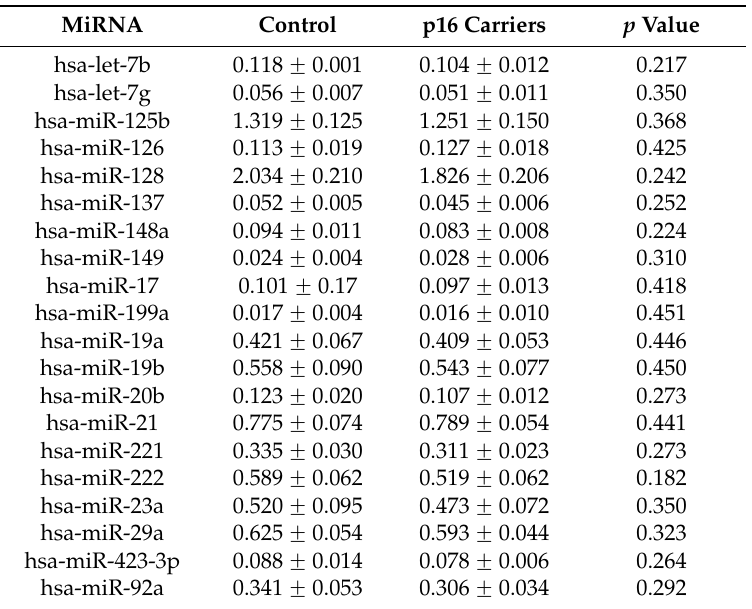
Table 3. MiRNA expression in plasma-derived exosomes from p16 mutation